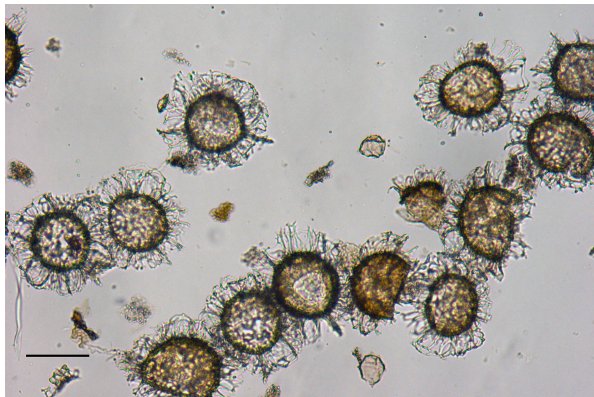
Figure 1. Microphotograph of the Thalassiphora pelagica assem- blage from the Kerguelen Plateau prior to purification with a sieve with 50µm pore size. Scale bar =